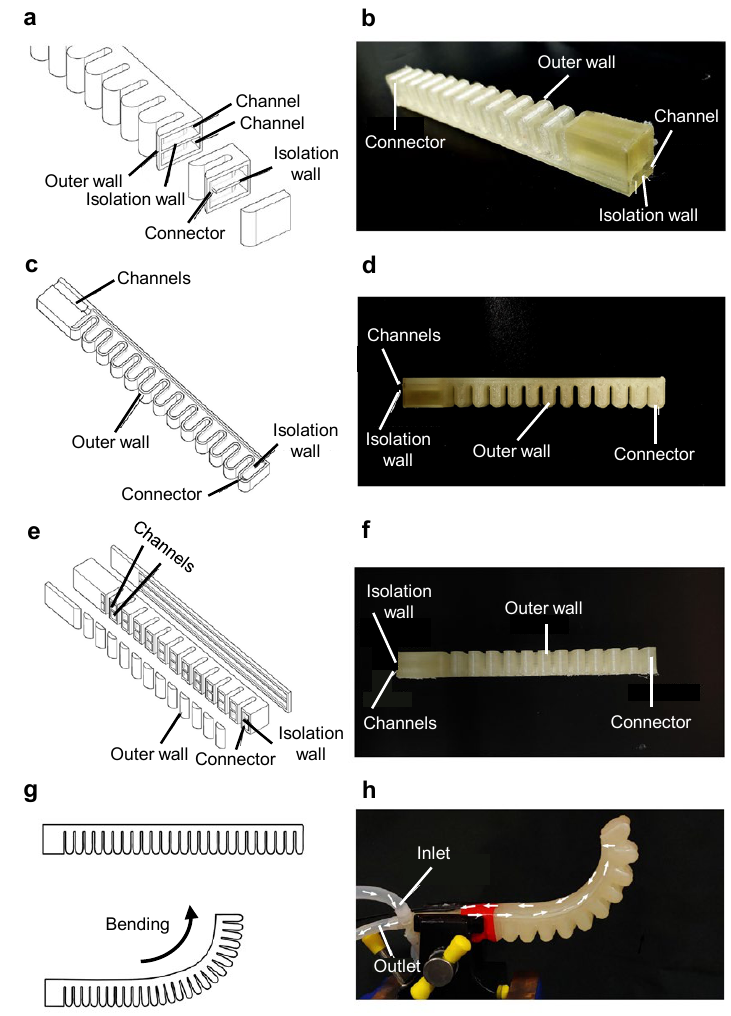
Figure 2. The design and working of the actuator. ( a ) Cross-section of the actuator showing the channel for the input fluid. ( b ) An optical photo of the 3D printed actuator showing its structure with inlet and outlet channel. ( c ) The actuator’s schematic shows the channels’ design, the connection between the two channels to facilitate fluid flow. ( d ) An optical photo showing the side view of the 3D printed actuator. ( e ) The axial section of the actuator showing the detailed structure of the channels and connectors. ( f ) An optical photo showing the top view of the 3D printed actuator. ( g ) Schematic showing the bending of the actuator. ( h ) An optical photo showing the side view of the bending actuator with arrows representing the input fluid